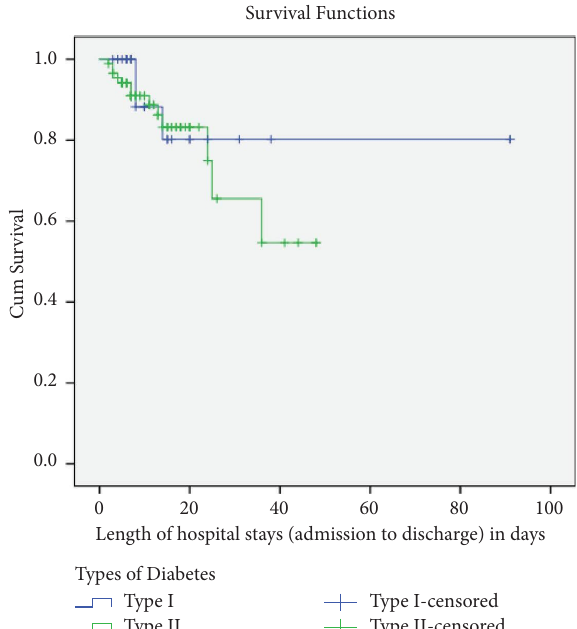
Figure 5: Kaplan–Meir survival curve for T1DM and T2DM patients admitted to JMC from October 01, 2020, to June 30, 2021. Table 7: Bivariate and multivariable Cox proportional hazard regression to identify predictors of in-hospital mortality among DM patients admitted to JMC from October 01, 2020, to June 30,